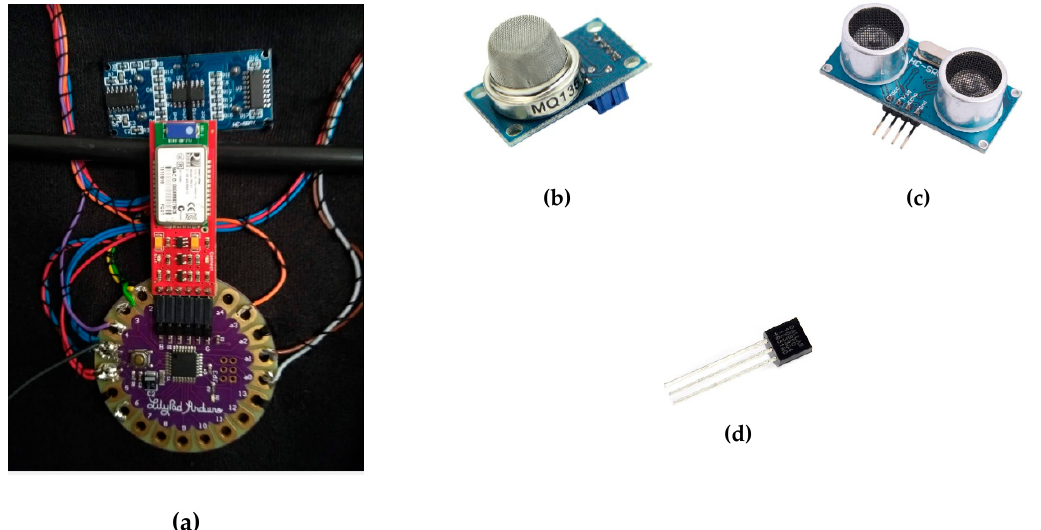
Figure 10. ( a ) An Arduino LilyPad and the wire connection of the sensors; ( b ) An MQ-135 air quality sensor; ( c ) An HC-SR-04 ultrasonic sensor; ( d ) a DS18B20 1-wire temperature